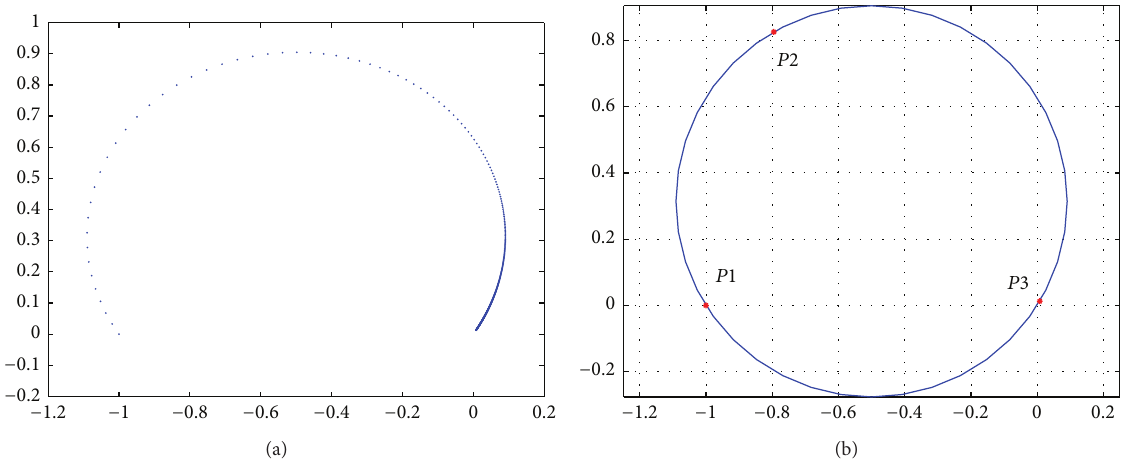
Figure 4: (a) The voltage round model of 𝑅3 component scanning, (b) the round model obtained by 𝑅3 three-point circle construction.